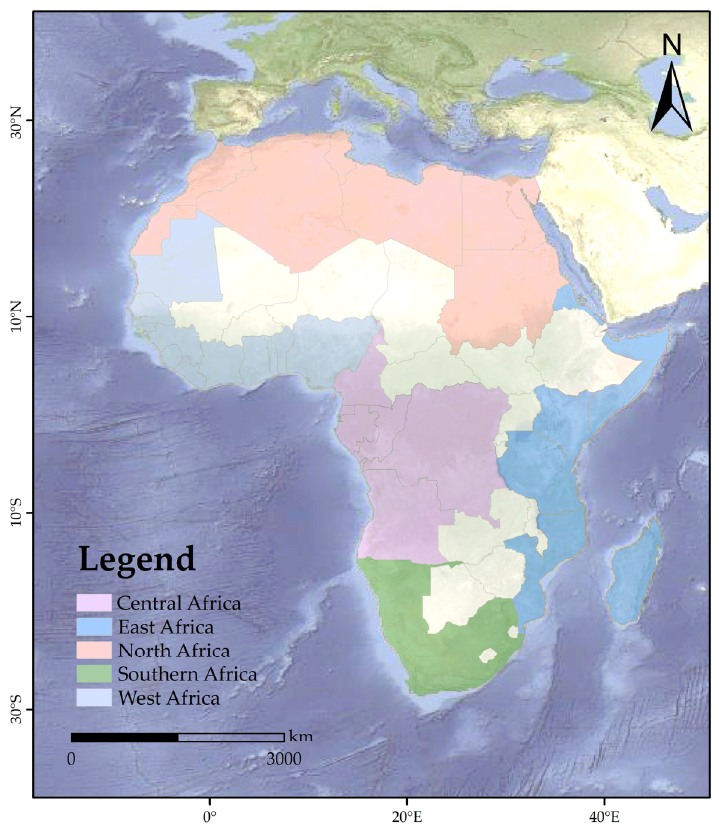
Figure 1. Map of the study site. The African countries studied in this paper were grouped into five major regions based on their geographical location. The countries with no coastline and no marine fishery were excluded from this study.